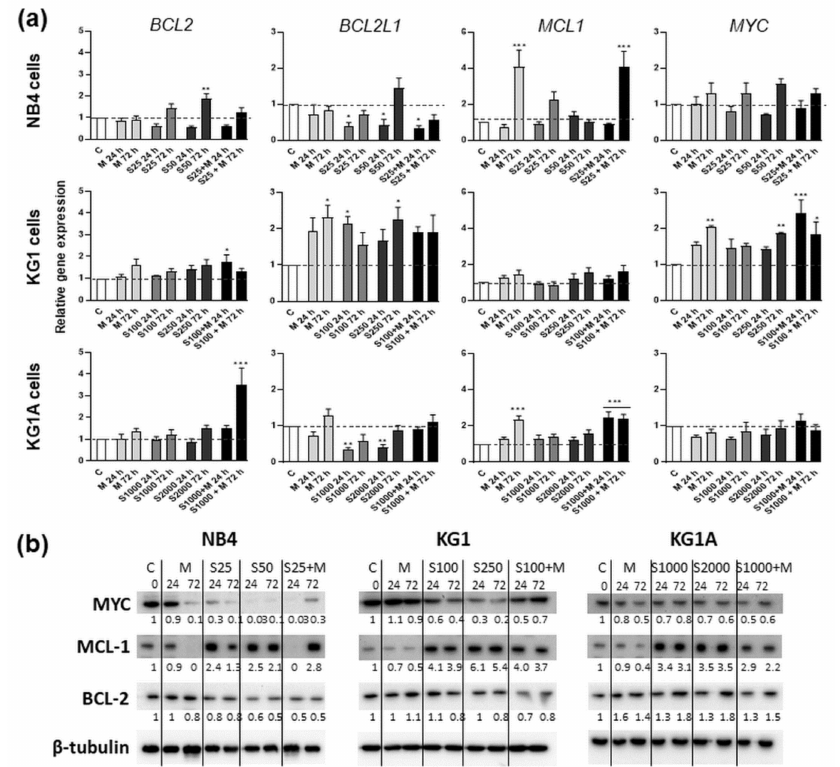
Figure 6. Anti-apoptotic gene and protein expression after treatment with metformin and MCL-1 inhibitor S63845. For subsequent analysis NB4 cells were treated with 25 nM and 50 nM S63845, 10 mM metformin and combination of 25 nM S63845 + 10 mM metformin. KG1 cells were treated with 100 nM and 250 nM S63845, 10 mM metformin and combination of 100 nM S63845 + 10 mM metformin. KG1A cells were treated with 1000 nM and 2000 nM S63845, 10 mM metformin and combination of 1000 nM S63845 + 10 mM metformin. C denotes control, untreated, cells. ( a ) Gene expression changes of apoptosis-suppressing genes BCL2 , BCL2L1 , MCL1 and MYC after 24 and 72 h of treatment were measured using RT-qPCR ∆∆ Ct method. HPRT1 gene expression was used for normalization; results are presented as relative changes in comparison to untreated cells; results are mean ± S.D. ( n = 3). ( b ) Protein level changes after cell treatment with S63845 and metformin were assessed by immunoblot. β -tubulin was used as a loading control. Protein band intensity was measured using ImageJ software; band intensity results were normalized according to β -tubulin from the same membrane ( n ≥ 2, representative results are displayed). Note: * denotes significant difference between treated vs. control cells with p < 0.05, ** denotes significant difference with p < 0.01, *** denotes significant difference with p < 0.005, as evaluated using 1-way ANOVA with Dunnett post hoc